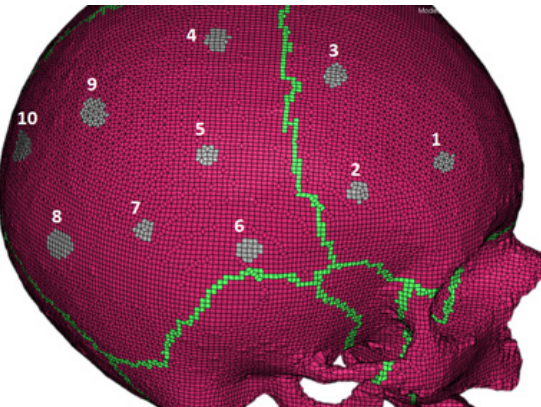
Table 3. Model thickness measurements in different skull locations.